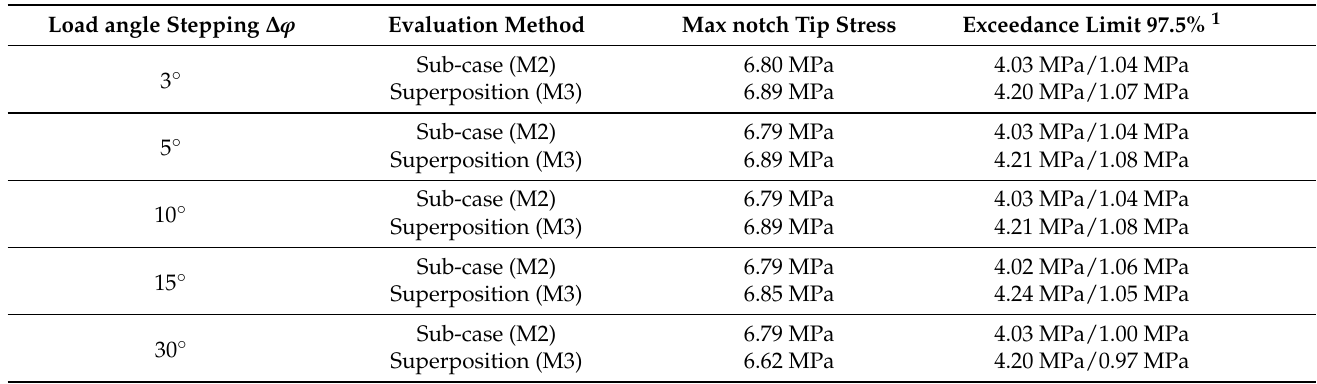
Table 7. Effect of load angle step on evaluated stress distribution of coarse-meshed elongated defect in a plate (refer to Figure 7d) for sub-case and superposition methods.